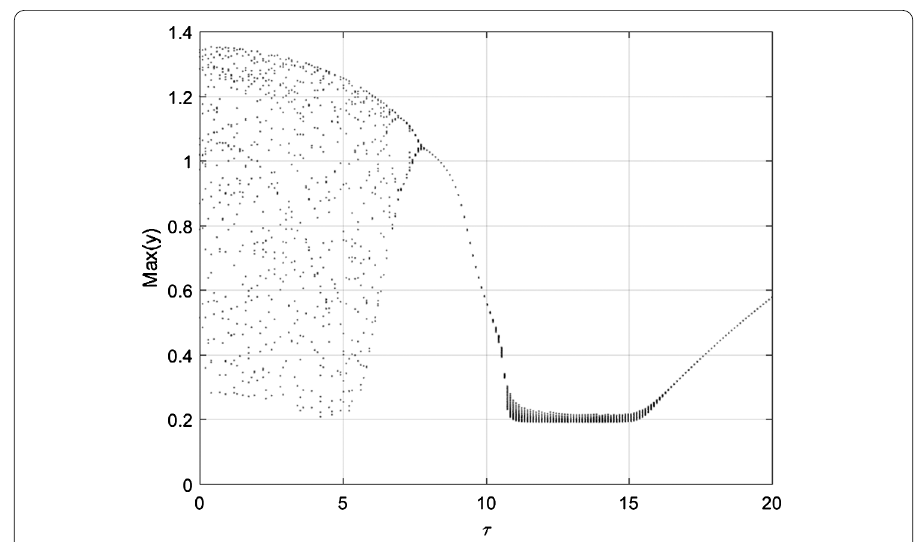
Figure 2 The bifurcation diagram of system (4.1), where w 1 = 1.4, w 2 = 5, w 3 = 8, w 4 = 1, w 5 = 0.16, w 6 = 0.1, w